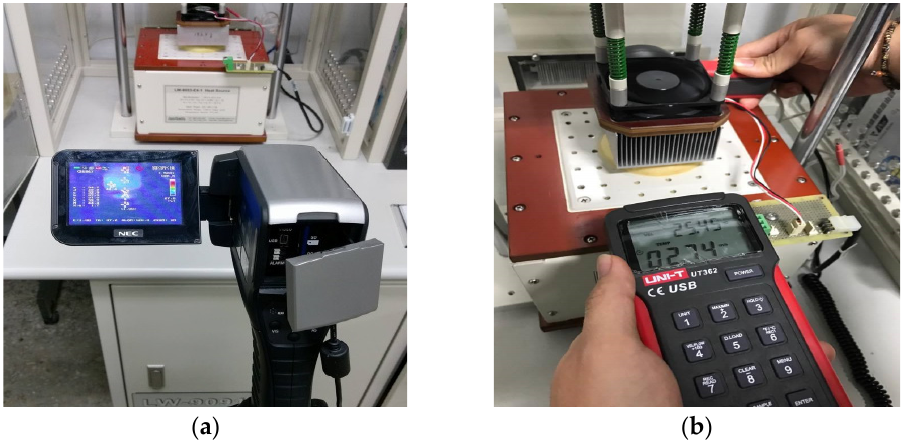
Figure 4. ( a ) actual temperature field of the heat sink using an infrared thermal image apparatus; ( b ) actual airflow velocity using an anemometer. Table 3. Response surface experiment